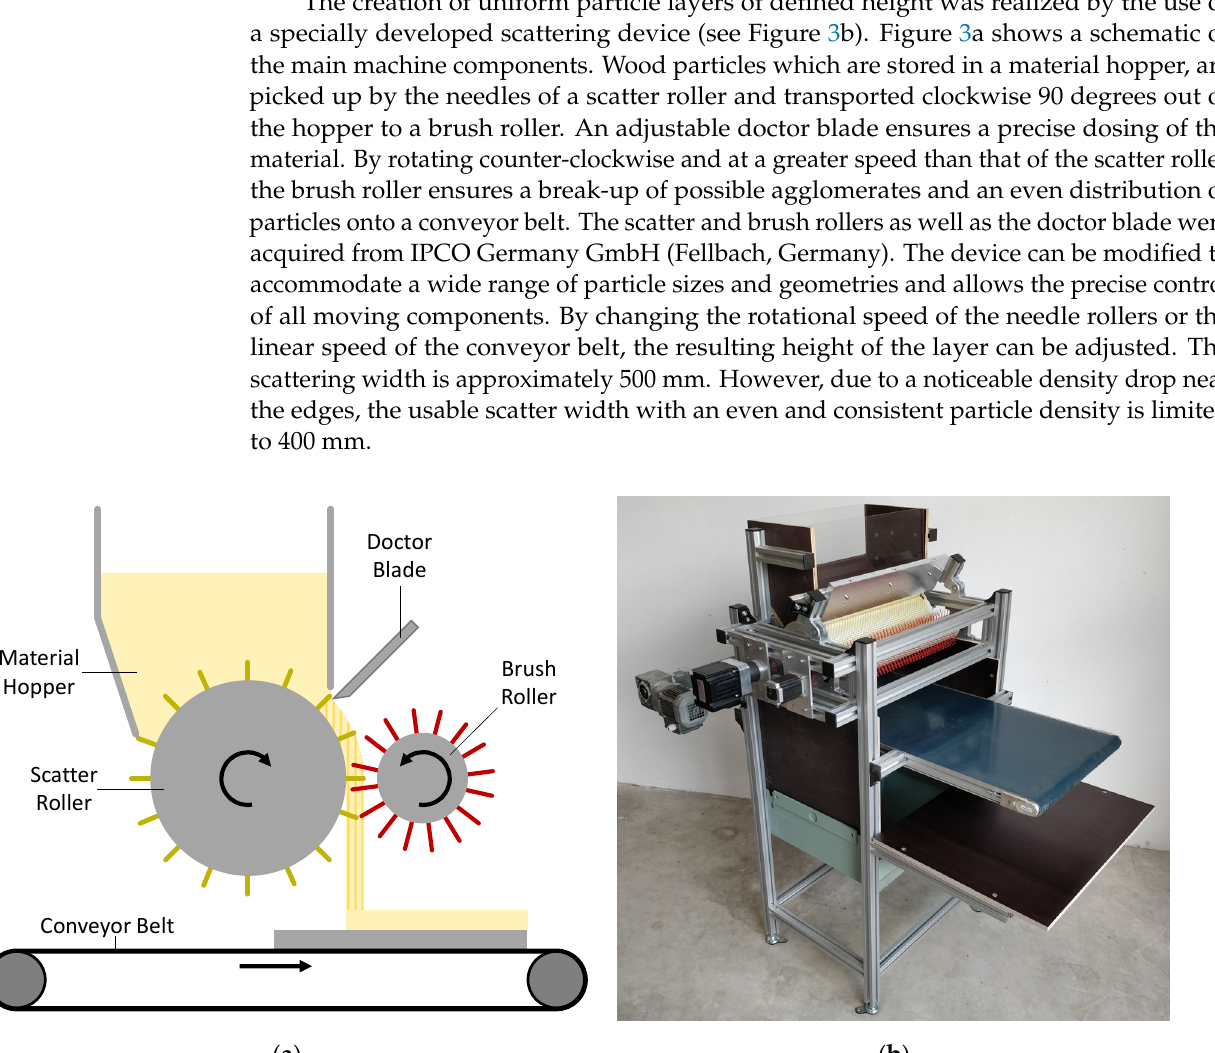
Figure 2. Demonstration objects for the ILF process with different panel thicknesses. While the panels were produced as described in the following sections, stacking and lamination were performed by hand with an epoxy resin as a binder.